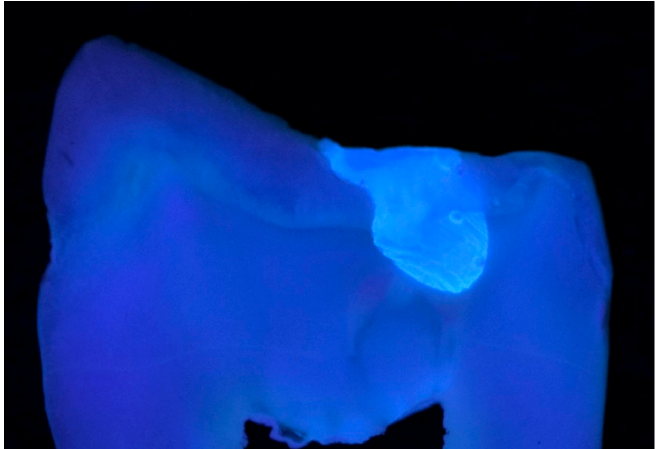
Figure 2. Image of a cross-section premolar slice in UV light (385 nm), revealing the differences in fluorescence between dental tissues and a restoration with Charisma ® . The digital equipment used was a DSLR camera (Nikon D3100) equipped with a macro objective (Tamron 90 mm), ISO 200, f/22, exposure time: 1/200 s.